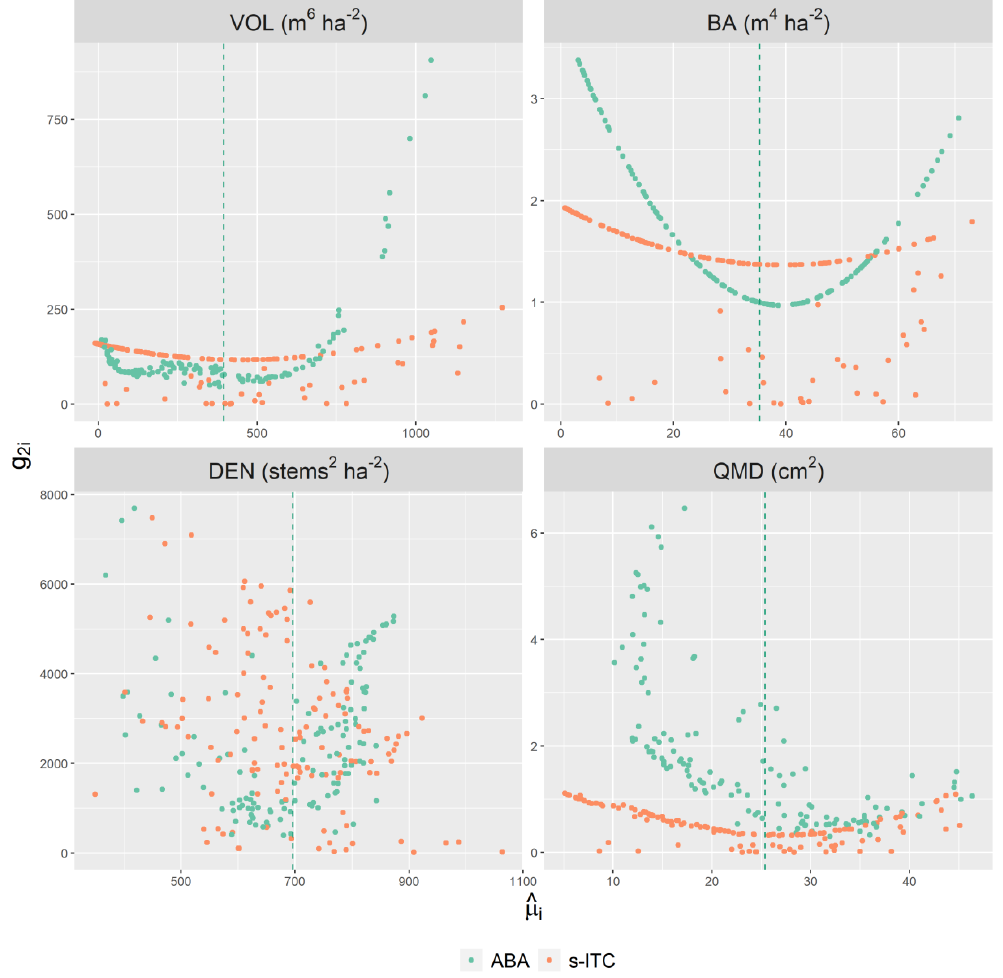
Figure 8. The error component g 2 i for all stands in the study area plotted against the stand-level prediction ˆ µ i . The prediction of the study region mean, ˆ µ τ , is shown for the ABA as a dashed vertical line as a reference.